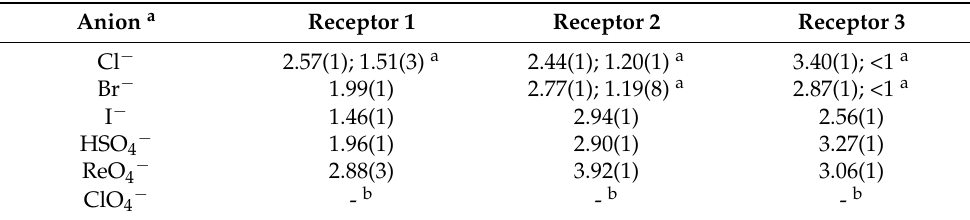
Table 1. Binding constants (log K ) of receptors 1–3 for anions as tetrabutylammonium salts determined by 1 H NMR titrations in CD 3 CN (8% of CDCl 3 ) at 25 ◦ C. Experimental errors estimated to be no more than ± 5% calculated for K (M − 1 ) from at least two independent